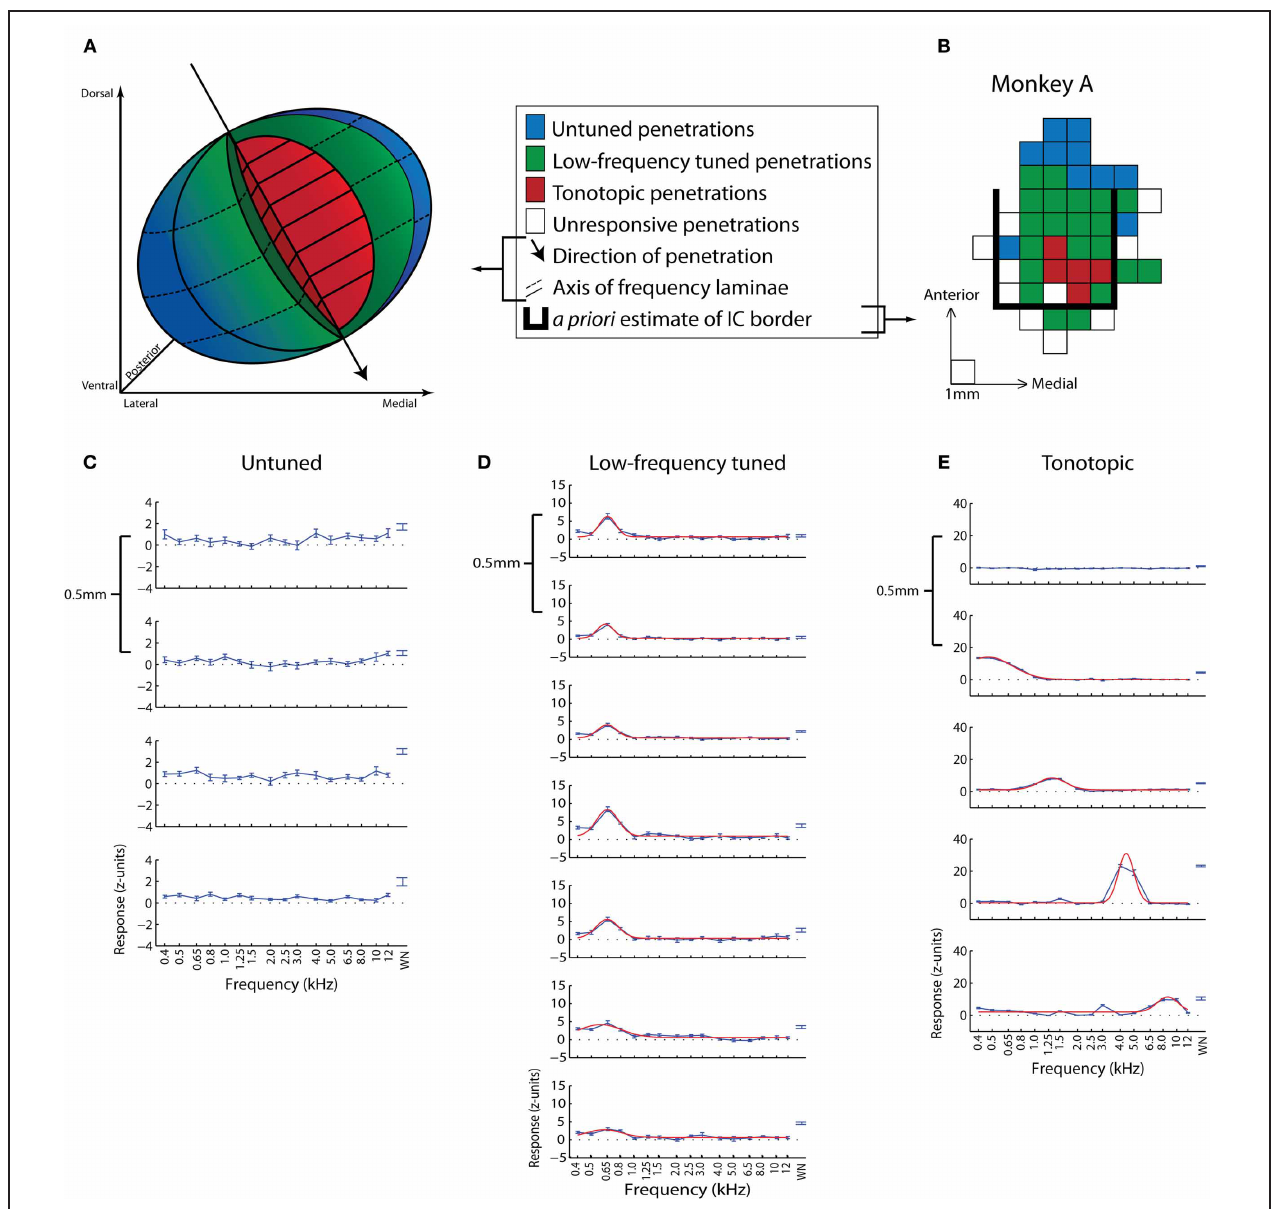
FIGURE 2 | Map of sound frequency representation in the monkey IC. (A,B) Three-dimensional schematic of sound frequency representation (A) based on a representative example dataset (B) from Bulkin and Groh (2011). Untuned sites are presumed to be in the outer sIC, low-frequency tuned sites from near the sIC-ICC border, and tonotopic sites from the center of the ICC. The grid in (B) is a top-down view of the recording grid for one monkey in the study. Each square represents a penetration site and is colored based on the response properties of that site. The bold black line delineates the a priori estimated boundaries of the IC based on MRI scans. (C–E) Example penetrations from untuned (C) , low-frequency tuned but not